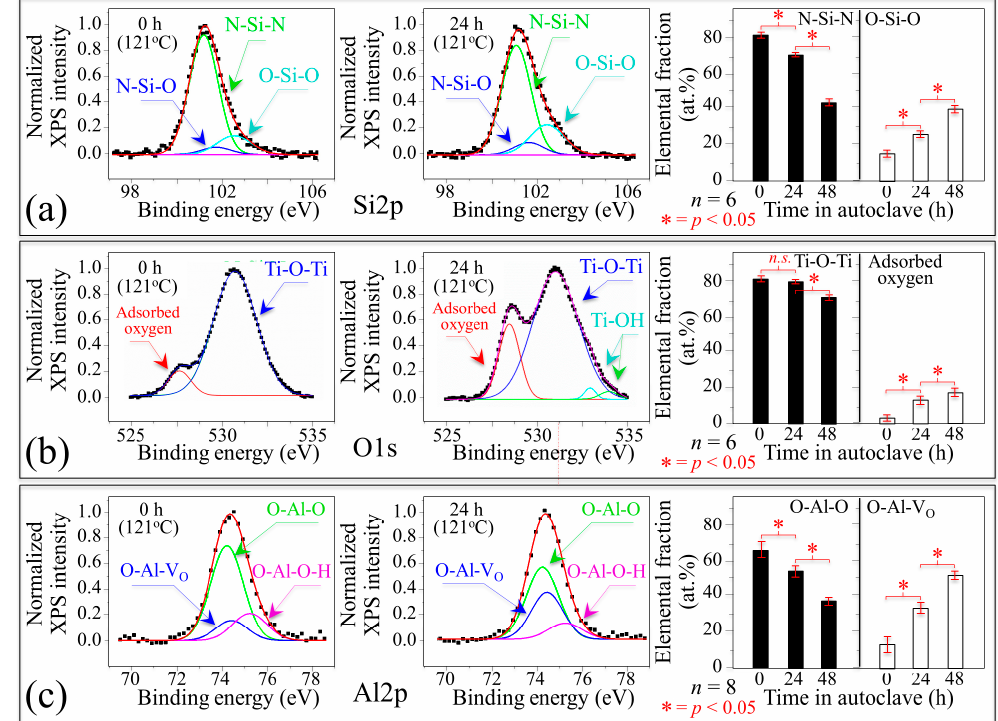
Figure 1. X-ray photoelectron spectroscopy (XPS) analyses of the investigated substrates before (left) and after (center) accelerated tests in water vapor environment, and plots summarizing elemental fraction results at different autoclaving times (right): ( a ) Si2p core spectrum of silicon nitride; ( b ) O1s core spectrum of Ti6Al4V alloy; and ( c ) Al2p core spectrum of alumina, with the related deconvolutions and quantitative time dependencies. Statistics were made according to the one-way Analysis of Variance (ANOVA) to assess the plots on the right side of each section.